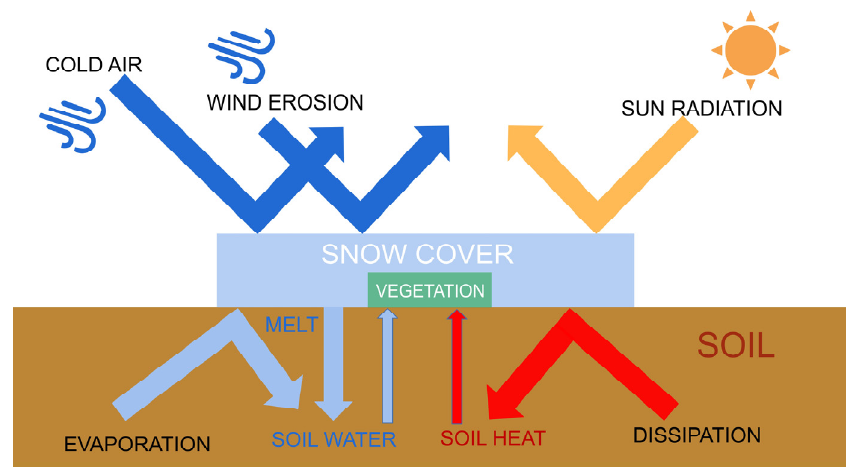
Figure 1. Schematic diagram of snow cover effects.